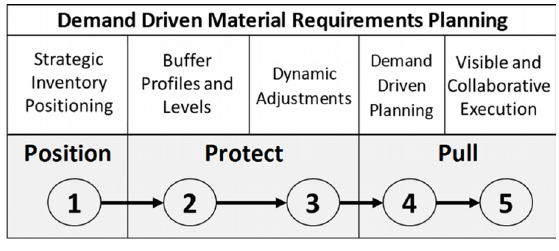
Figure 2. The five phases of DDMRP (Ptak & Smith,